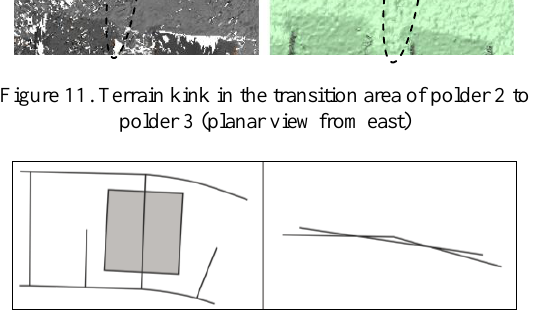
Table 5. Deviations of both surfaces with respect to each adjusted plane at the investigation area „terrain kink“ at the western embankment of polder